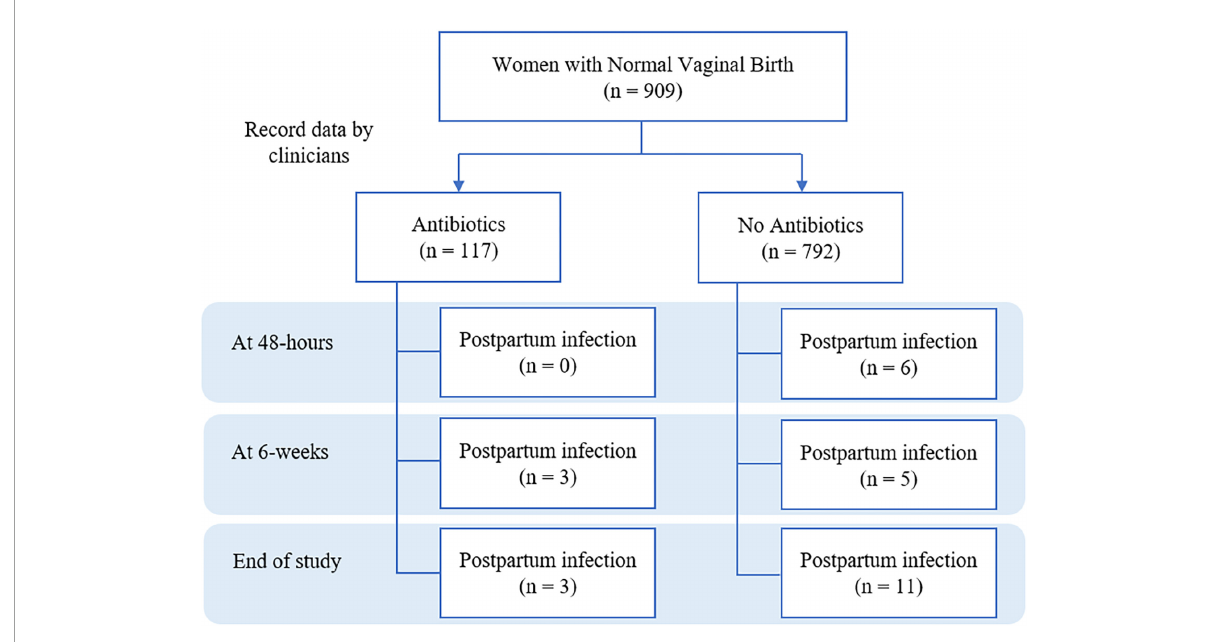
FIGURE1 Flow chart of study on incidence of postpartum infection between antibiotics and no antibiotics prescribing.